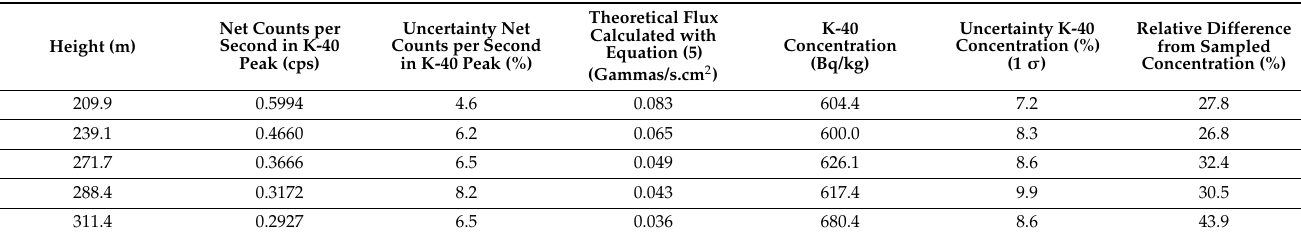
Table 3. Table comparing K-40 concentration measurements at multiple heights with the sampled concentration of